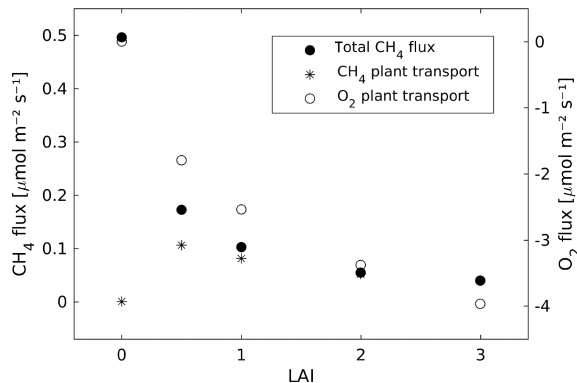
Figure 11. Dependence of total and plant-transported fluxes of CH 4 and plant transport of O 2 on LAI in test L_W0_T10_R1.